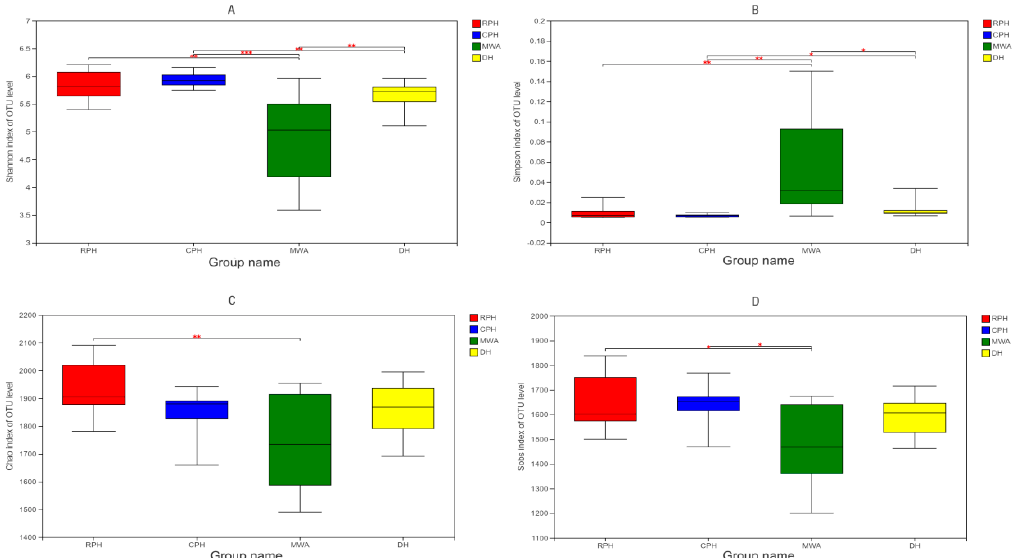
Figure 2. Box plot of alpha diversity indexes. ( A ) Shannon and ( B ) Simpson indexes reflect the diversity of OTU in samples. ( C ) Chao and ( D ) Sobs indexes reflect the OTU abundance in samples. The colors red, blue, green and yellow represent RPHs, CPHs, MWAs and DHs, respectively. * p < 0.05, ** p < 0.01 and *** p < 0.001.